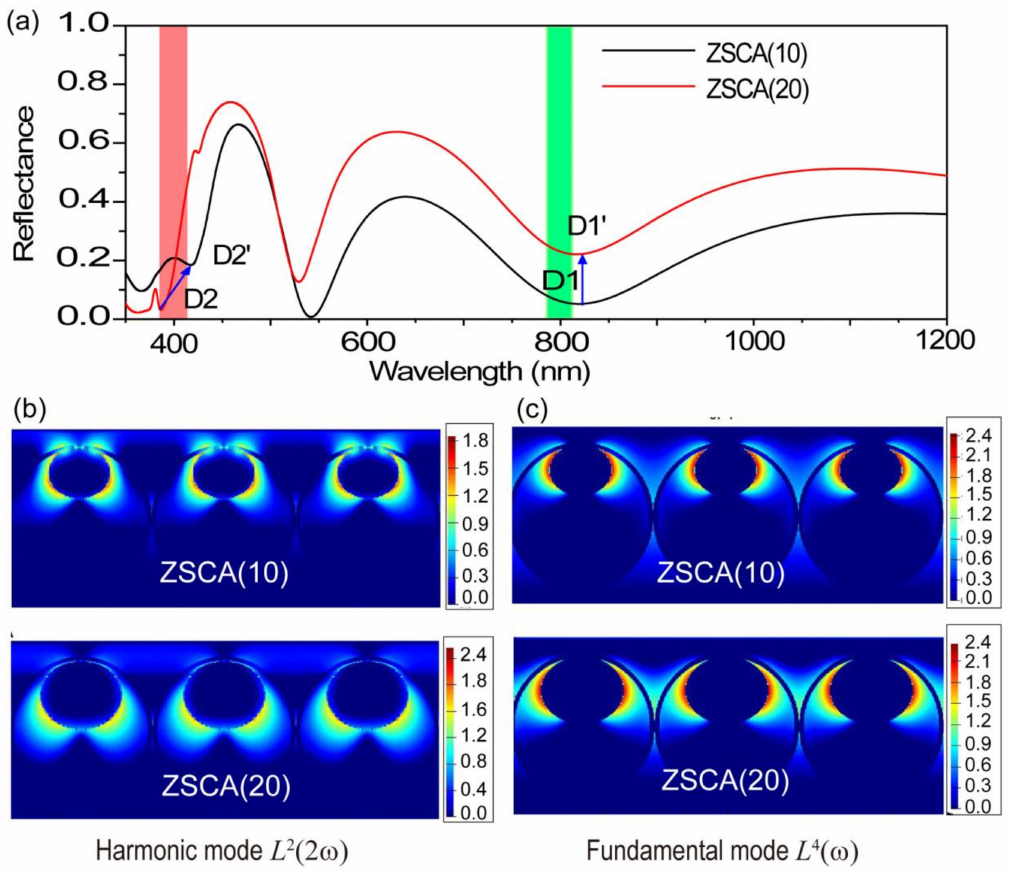
Figure 6. ( a ) Simulated reflectance spectra for ZSCA(10) and ZSCA(20). Simulated near-field distributions of Ag-NP dependent PESHG-EF: ( b ) harmonic mode (400 nm) for ZSCA(10) and ZSCA(20); ( c ) fundamental mode (800 nm) for ZSCA(10) and ZSCA(20) at the logarithmic